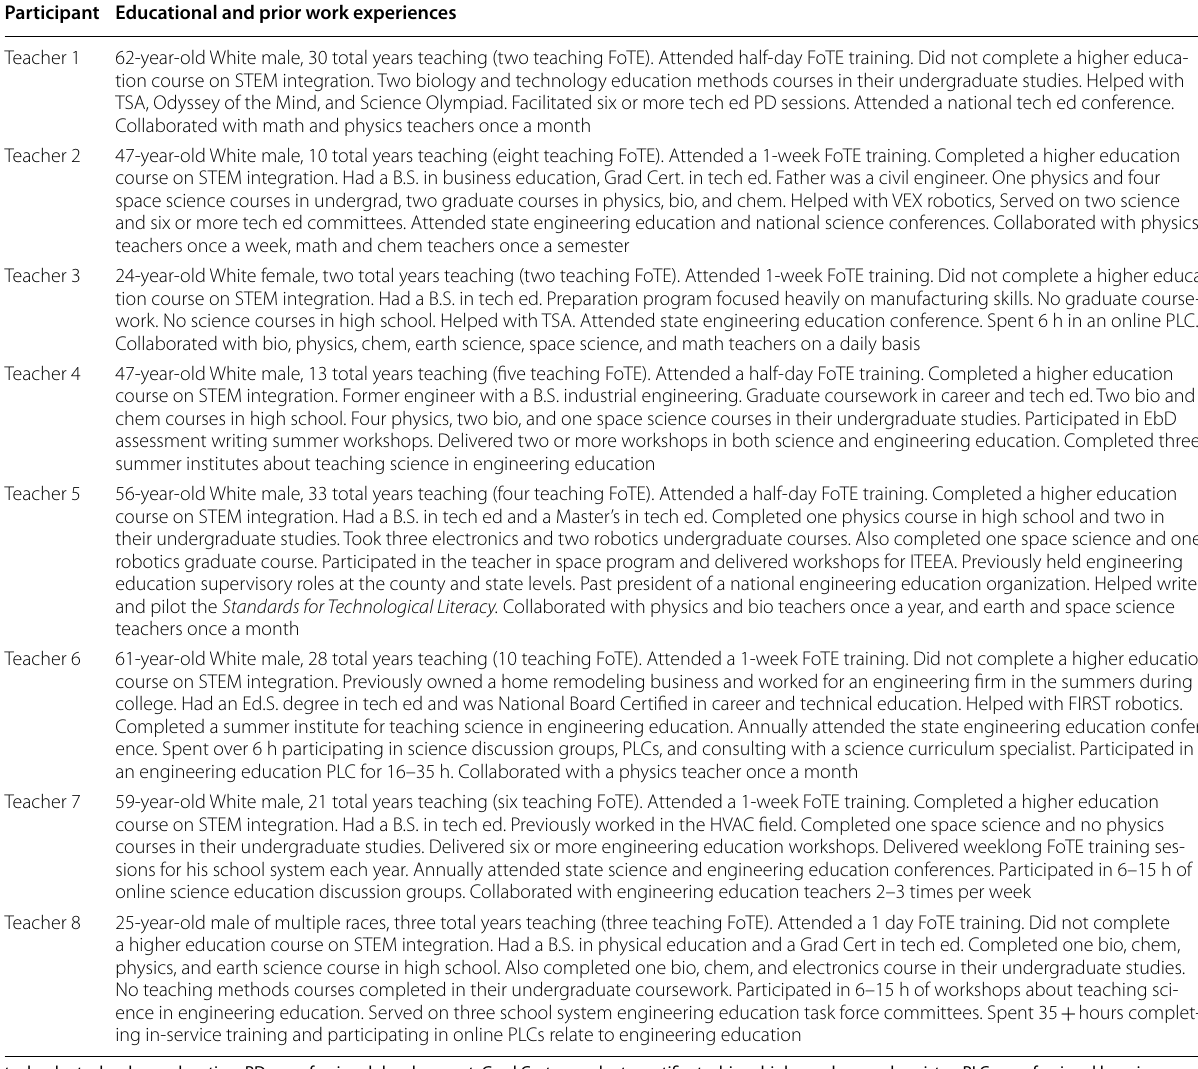
Table 3 Observed RTOP ratings for teaching engineering content and practice